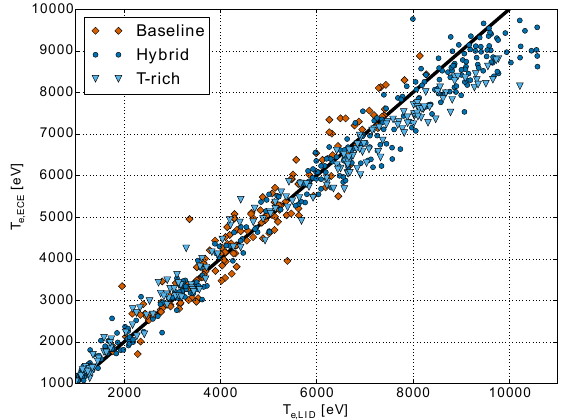
Figure 7: Comparison of peak temperatures for second and third harmonics X-mode in DD